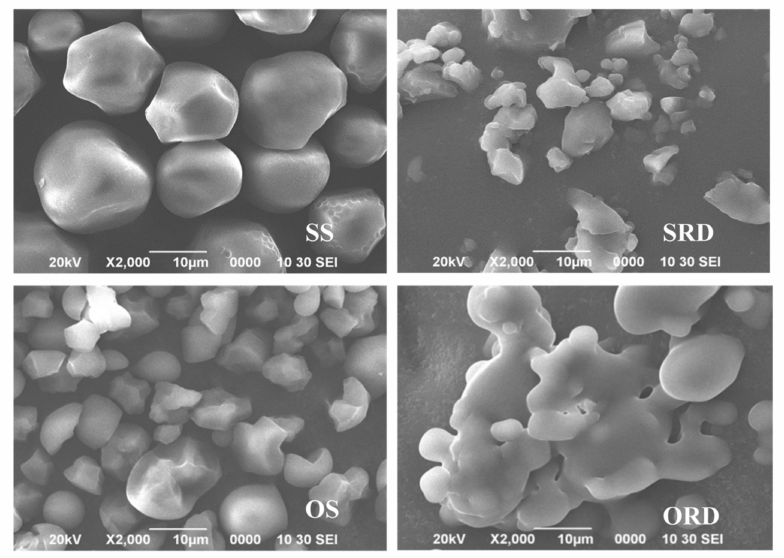
Figure 1. Scanning electron microscopy (2000 × ) of sorghum/oat starch and sorghum/oat resistant dextrin. SS: sorghum starch; SRD: sorghum resistant dextrin; OS: oat starch; ORD: oat resistant